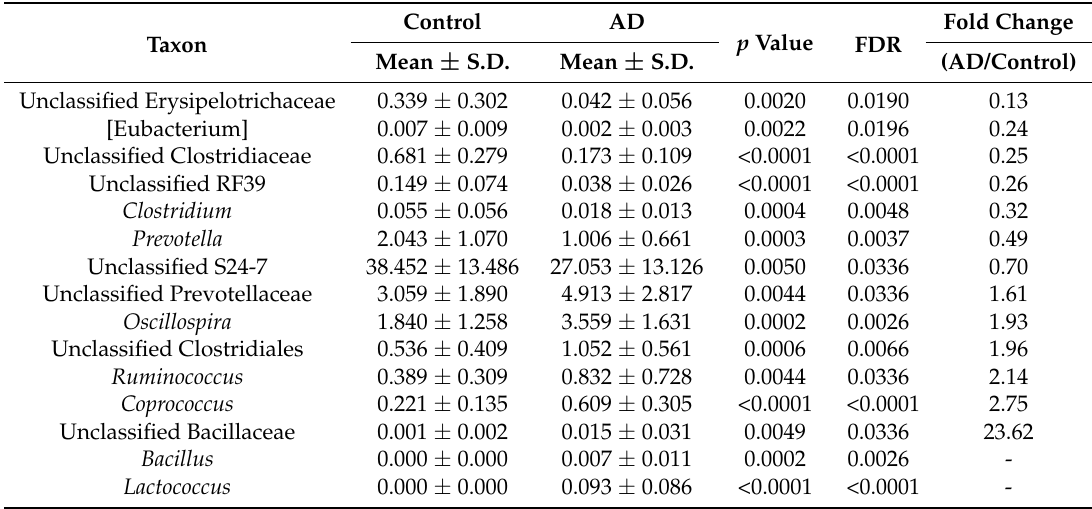
Table 2. Relative abundance of microbial taxa that differ significantly between control and AD mice. Control AD Taxon